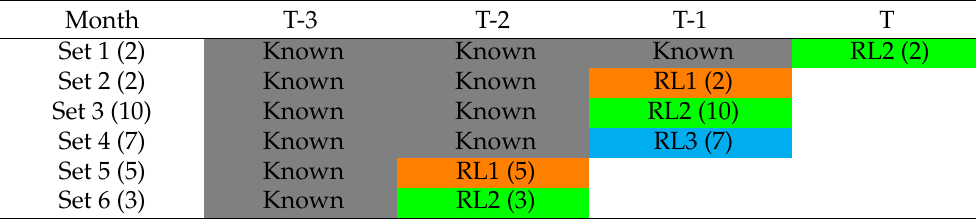
Table 6. Data transformation types: x ∗